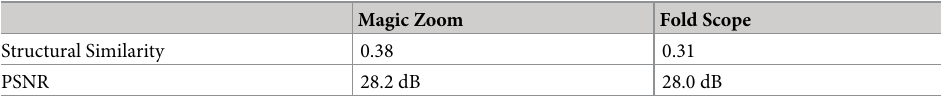
Table 2. Average comparative image quality metrics—microscopic compared with Foldscope and Magic